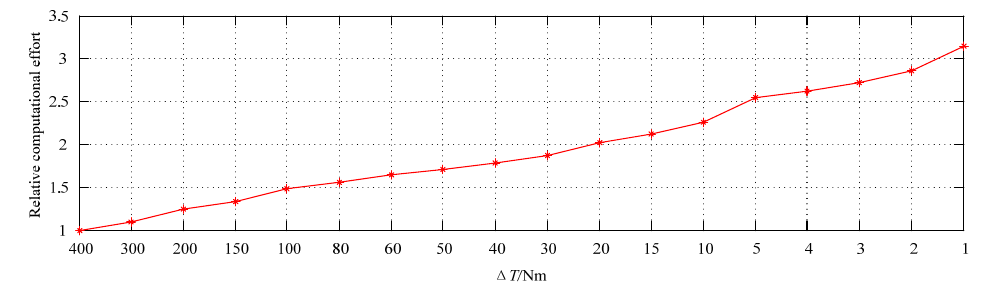
Figure 13. The results calculated by DP with different T  .